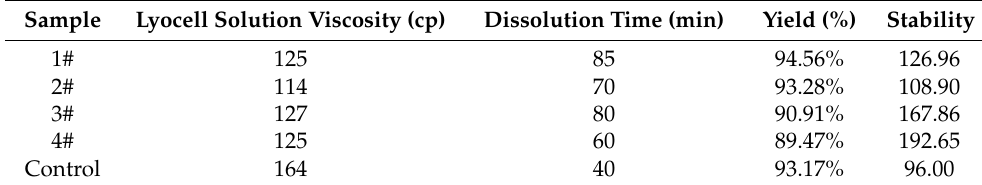
Table 4. Characterization of dissolution